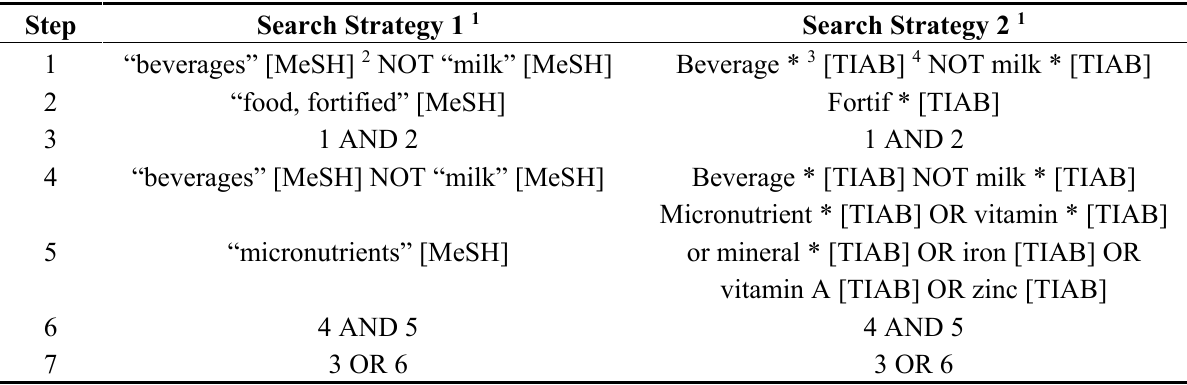
Table 1. PubMed search